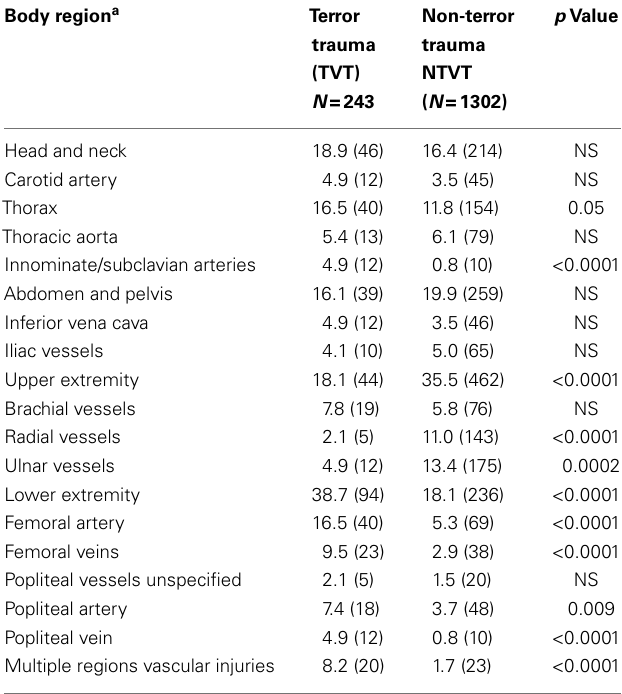
Table 4 | Body regions of vascular trauma and prominent injured vessels –TVT vs. NTVT groups (%, number)